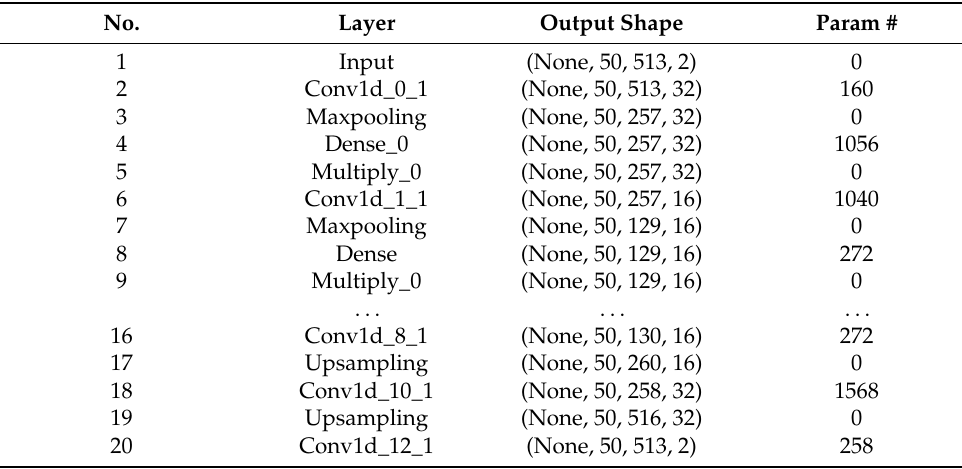
Table 3. Parameters of the encoder in proposed